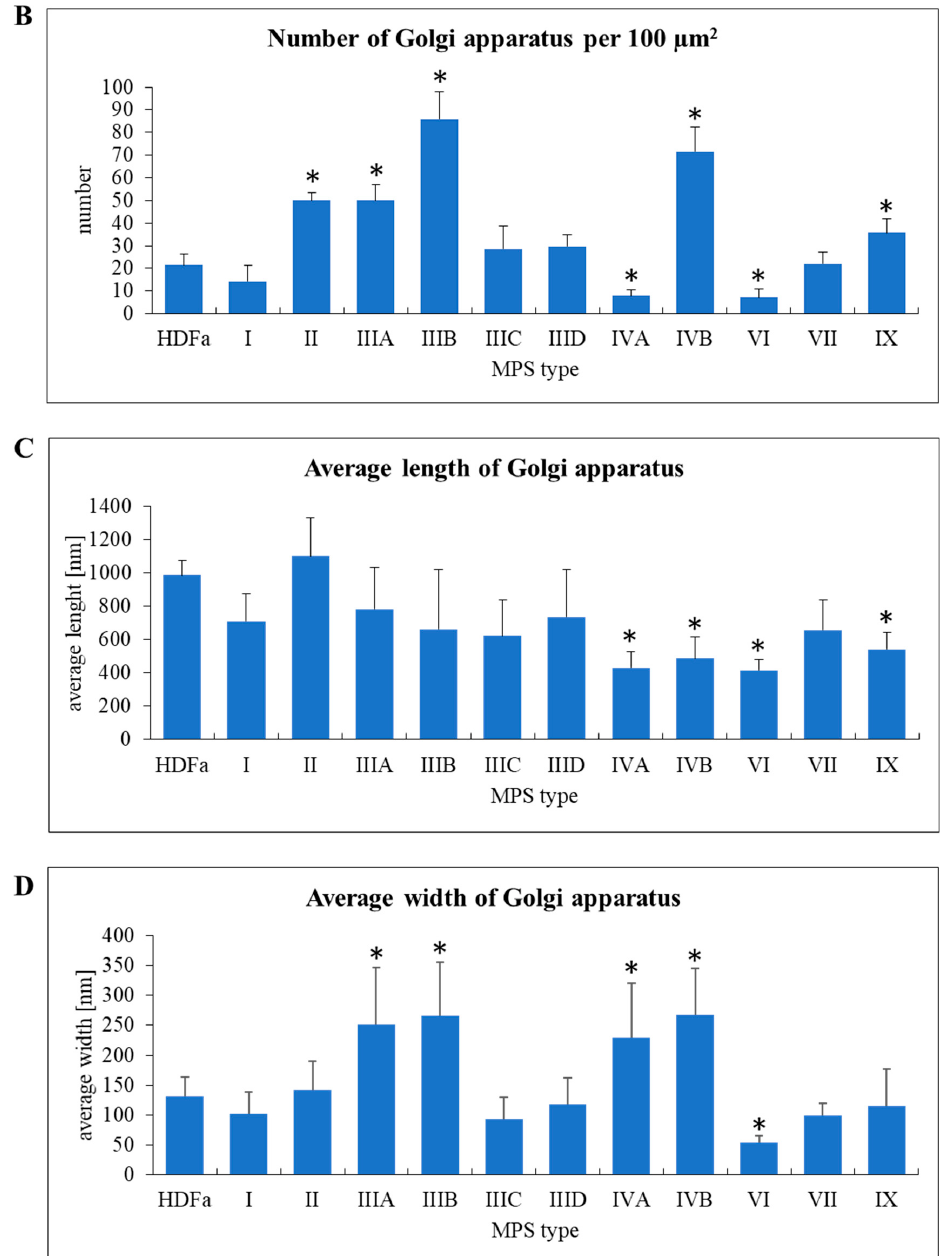
Figure 8. Morphology of Golgi apparatus in MPS fibroblasts in comparison to control cells (HDFa cell line). Representative electron micrographs are presented in ( A ) (size bars represent 200 nm; arrows indicate Golgi structures). Quantification of changes in Golgi structures is presented in ( B – D ), indicating their number ( B ), length ( C ) and width ( D ). Mean values ± SD are presented, with asterisks representing statistically significant ( p < 0.05) differences relative to the HDFa control. When considering endoplasmic reticulum, we assessed area covered by this cellular structure to find that it was bigger in MPS I and IIIB, and smaller in MPS IIID and VII (Figure